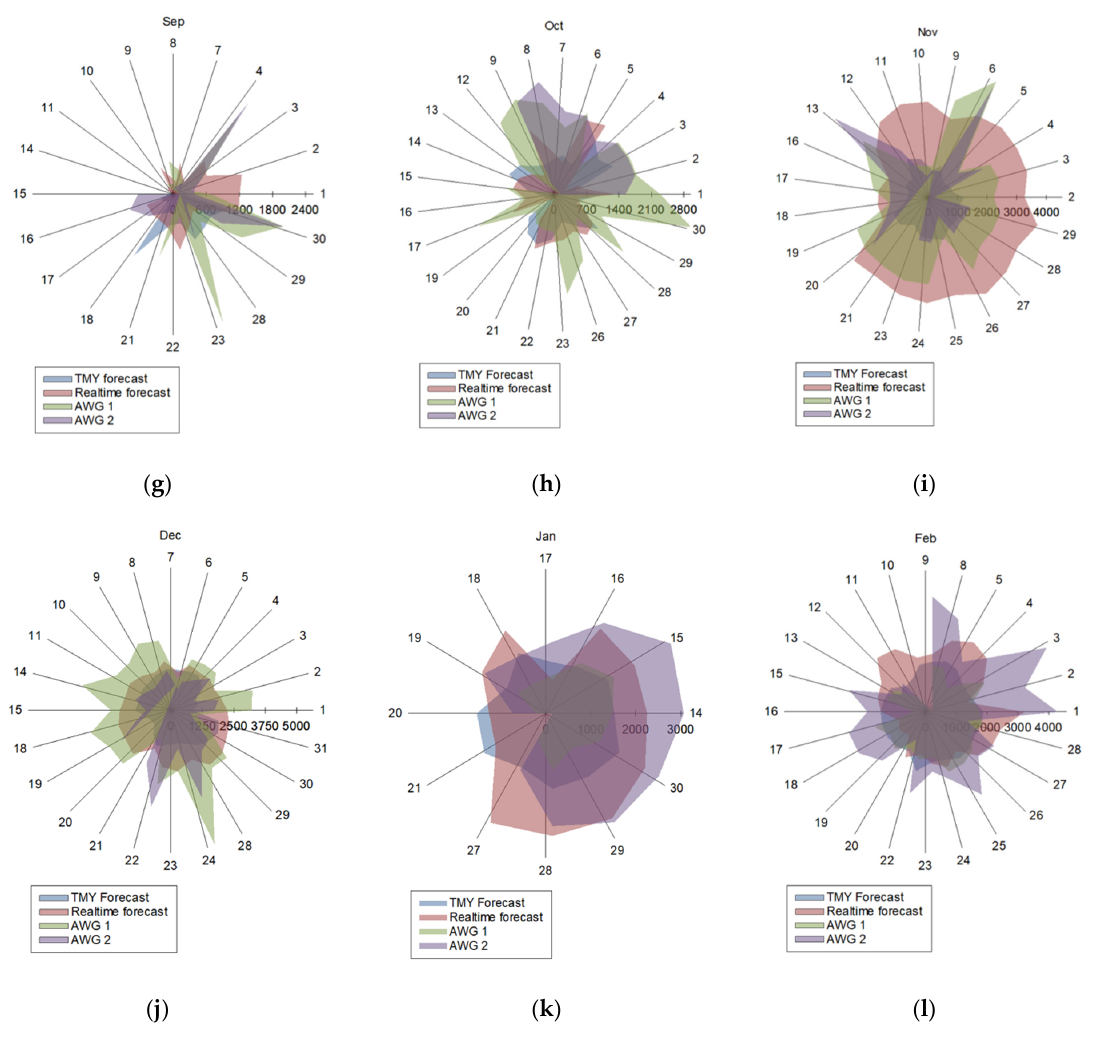
Figure 7. Comparison between apparent and real water yield under modified conditions